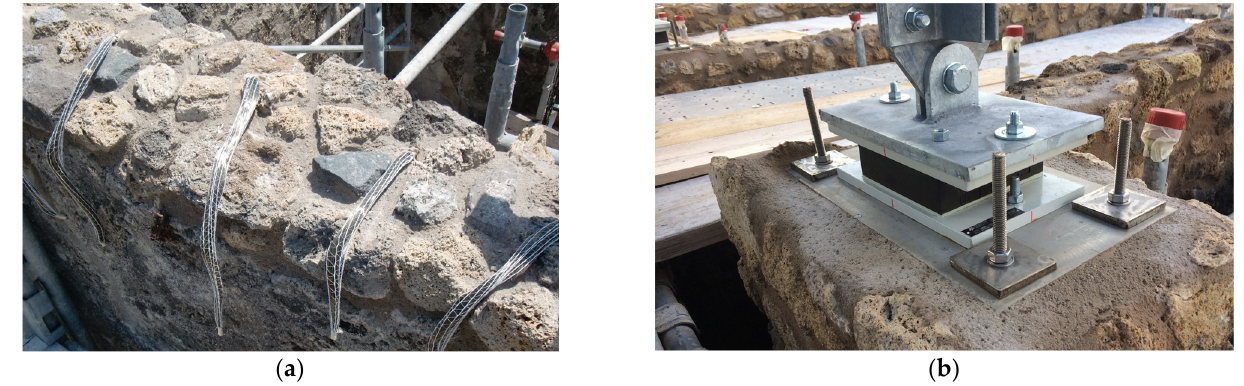
Figure 11. ( a ) Basalt fiber ropes in the masonry top wall. ( b ) The rubber support device.